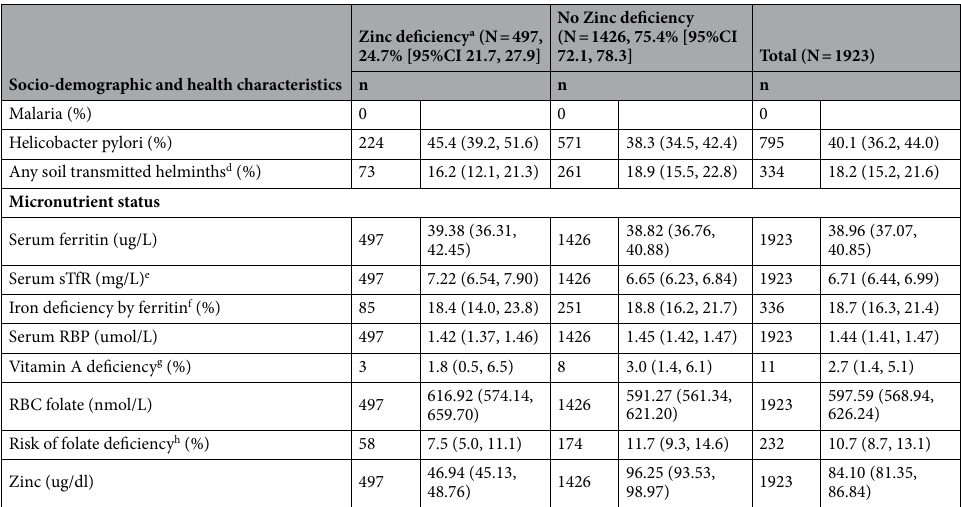
Table 3. Sociodemographic and health characteristics of NPW aged 15–49 years by the status of zinc deficiency, Nepal National Micronutrient Status Survey, Nepal, 2016. Ns are unweighted. Values presented are mean (95%CI) or percent(95%CI). All estimates account for weighting and complex sampling design. AGP ɑ -1 acid glycoprotein, BMI Body Mass Index, CI confidence interval, CRP C-reactive protein, RBC red blood cell, RBP retinol-binding protein. a Zinc deficiency defined as serum zinc < 66.0 μg/ dL for nonfasted, morning (i. e. before 12 pm) samples and < 59.0 μg/ dL for non-fasted, afternoon (i. e. after 12 p.m.) samples 38 . b Hemoglobin adjusted for altitude and smoking 39 . c Anemia defined as altitude-and smoking-adjusted Hb < 12.0 g/dL 39 . d Soil- transmitted helminths including hookworm, Trichuris trichura, and Ascaris lumbricodes. e Biomarker was regression-adjusted to a pooled country reference to adjust for inflammation, using CRP and AGP (ferritin) or AGP only 40 . f Iron deficiency defined as inflammation-adjusted serum ferritin < 15.0 μg/L 39 . g Vitamin A deficiency was defined as RBP < 0.64 μmol/L. h Folate cut off based on the risk of megaloblastic anemia defined as RBC folate < 305.0 nmol/L 41